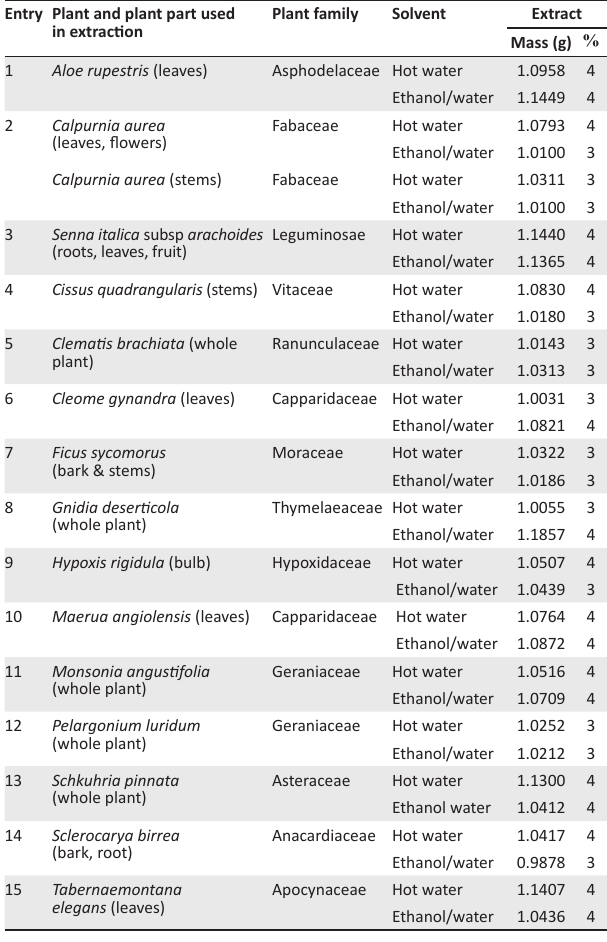
TABLE 1: Plant species, plant part used for the solvent extraction, plant family, the mass and percentage of extract obtained. Entry Plant and plant part used in